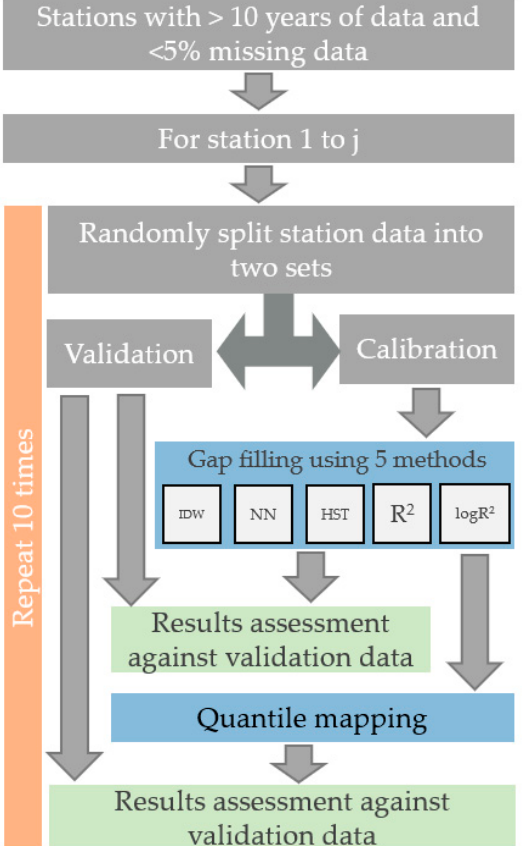
Figure 3. Step by step procedure followed. In blue, the two discrete processing steps mentioned in methodology. In green, the assessment of the results after each of the two steps.